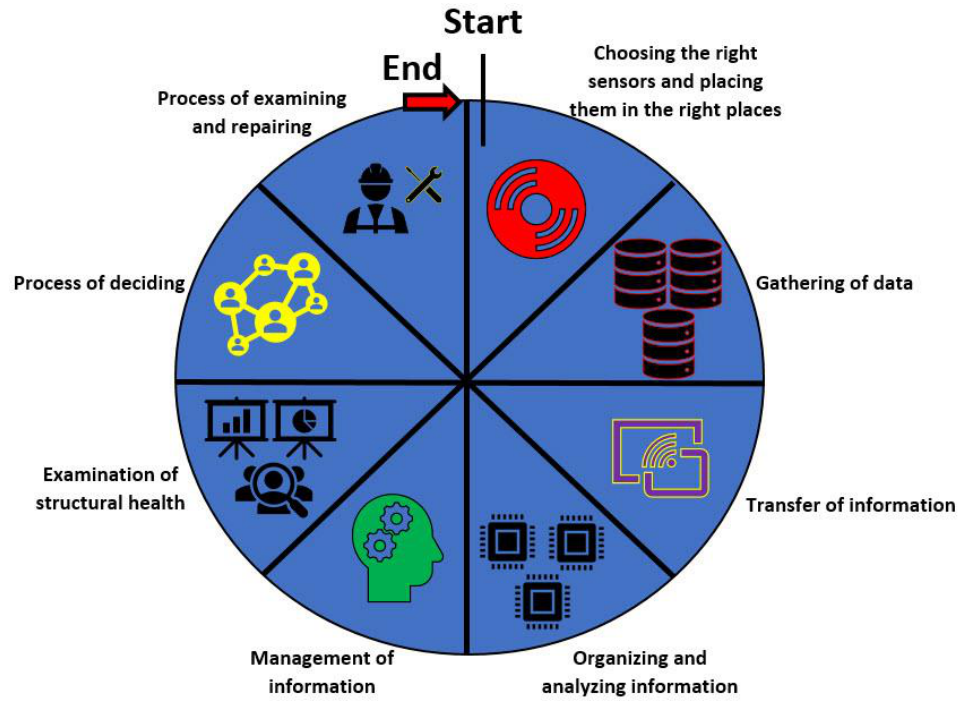
Figure 2. A summary of the procedure of the SHM system to monitor the functioning of bridges.